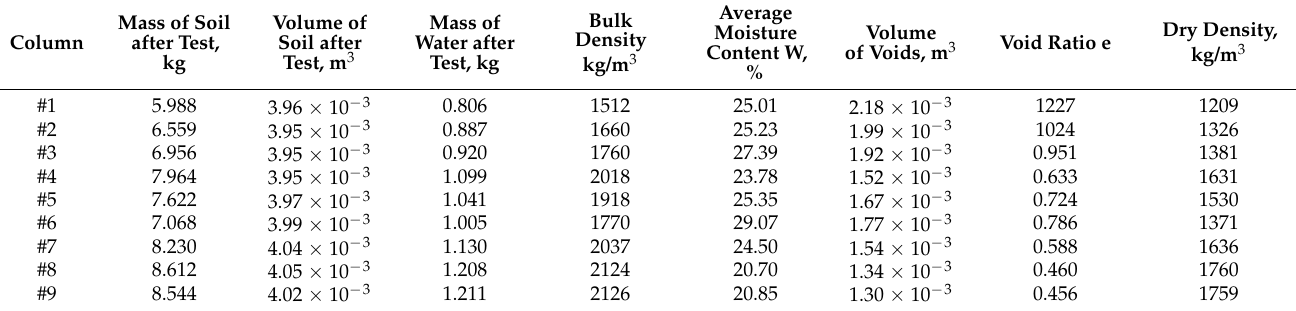
Table 3. Volumetric parameters of soil columns after two freeze–thaw cycles.